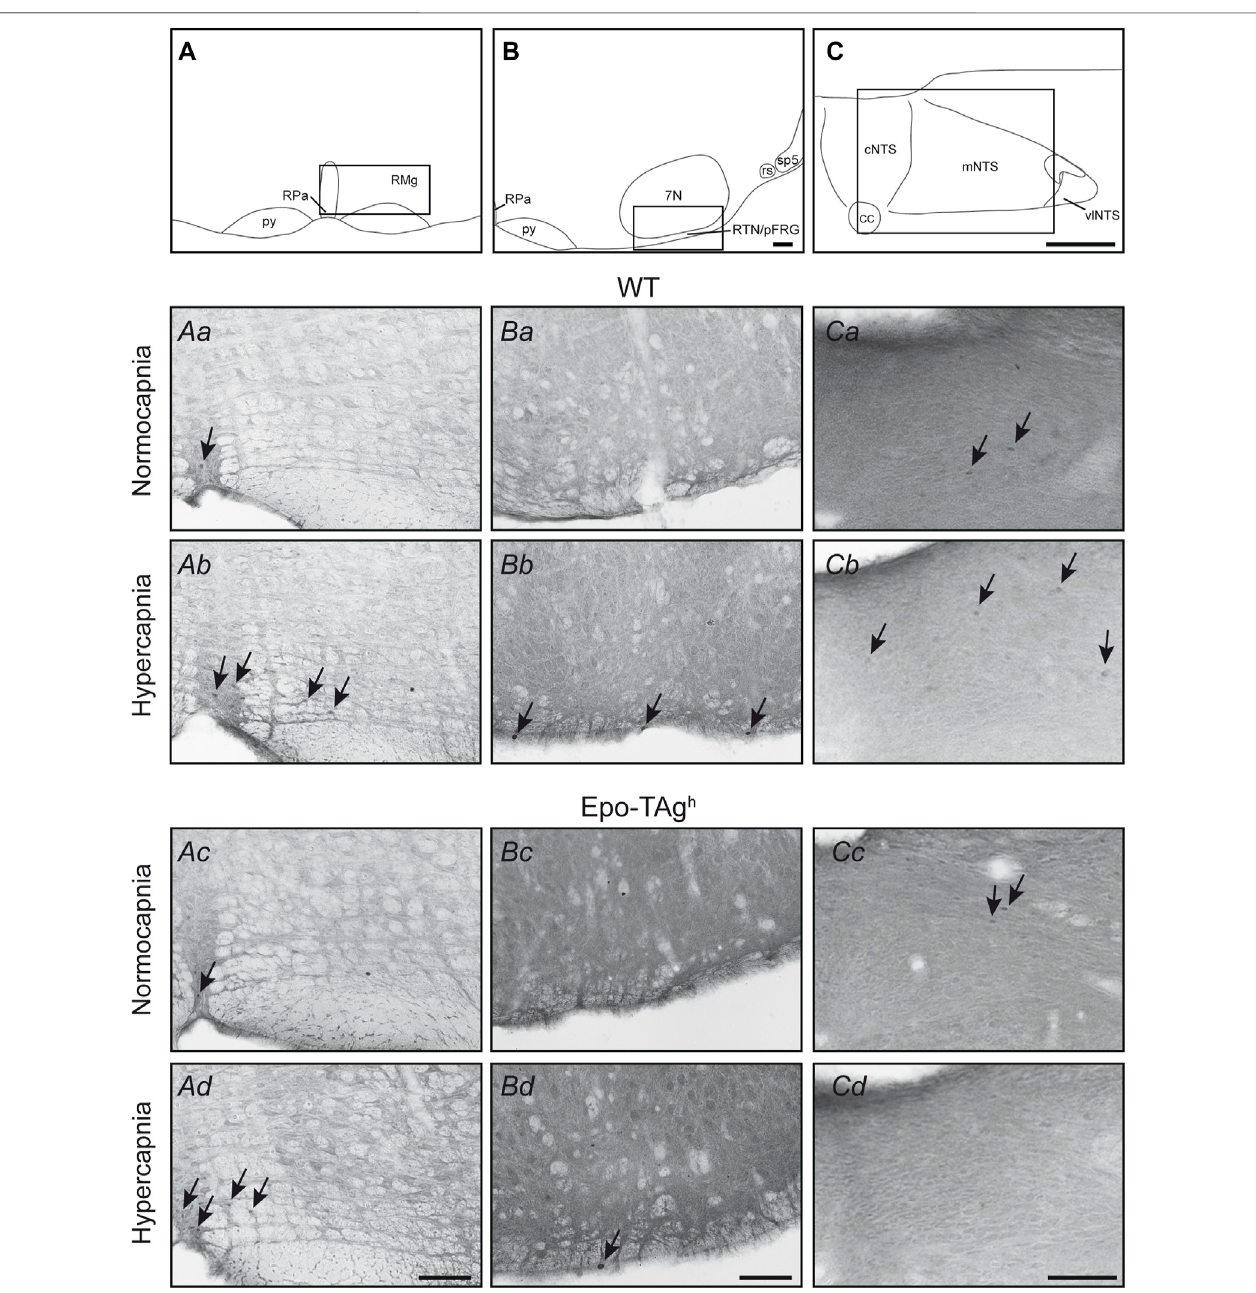
FIGURE 2 | Epo de fi ciency affected the medullary respiratory network activated by hypercapnia. Drawings locating the structures illustrated in the microphotographs below, raphe pallidus and magnus nuclei (A) , retrotrapezoid nucleus/parafacial respiratory group (RTN/pFRG) (B) , and nucleus of the solitary tract (C) . The black box de fi nes the photographed areas. Photomicrographs of sections immunolabelled for c-FOS in WT (Aa,Ba,Ca,Ab,Bb,Cb) and Epo-Tag h (Ac,Bc,Cc,Ad,Bd,Cd) micein raphemagnus andraphe pallidus nuclei (Aa – Ad) undernormocapnia (Aa,Ac) andhypercapnia (Ab,Ad) ,inretrotrapezoidnucleus/ parafacial respiratory group (Ba – Bd) under normocapnia (Ba,Bc) and hypercapnia (Bb,Bd) , and in nucleus of the solitary tract (Ca – Cd) under normocapnia (Ca,Cc) and hypercapnia (Cb,Bd) . Black arrows show some c-FOS-positive neurons. Scale bars = 100 µm. Abbreviations: 7N, facial nucleus; cc: central canal; cNTS, commissural part of the nucleus of the solitary tract; mNTS, medial part of the nucleus of the solitary tract; py, pyramidal tract; RMg, raphe magnus nucleus; RPa, raphe pallidus nucleus;rs,rubrospinaltract;RTN/pFRG,retrotrapezoidnucleus/parafacialrespiratorygroup;sp5,spinaltrigeminaltract;vlNTS,ventrolateralpartofthenucleus of the solitary